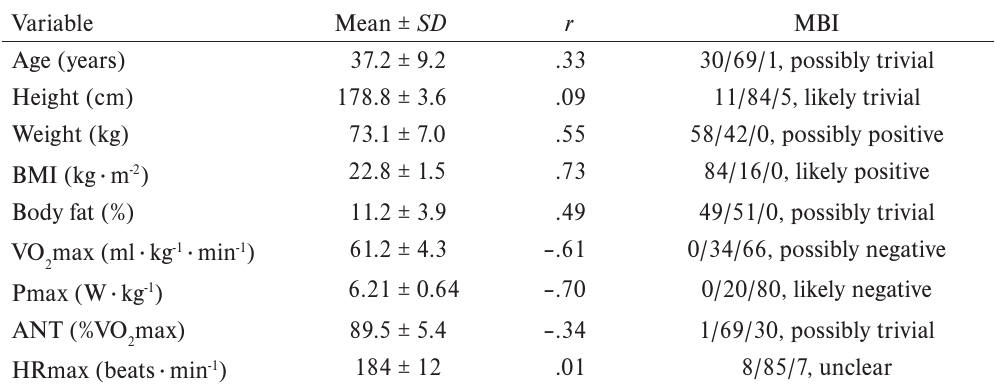
Somatic and physiological characteristics of the tested group (N = 10) and correlations with race time Variable